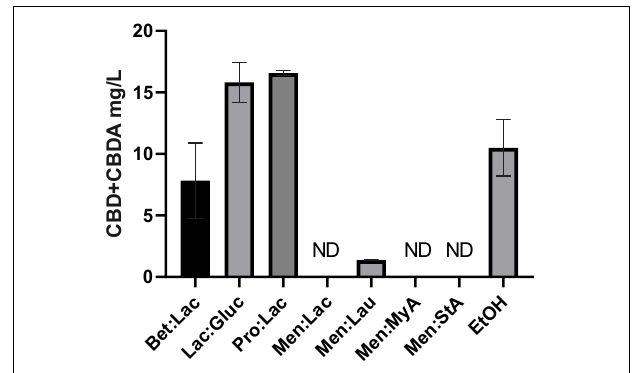
FIGURE 7 | Solubility of CBD + CBDA (mg/L) in PBS at 37 ◦